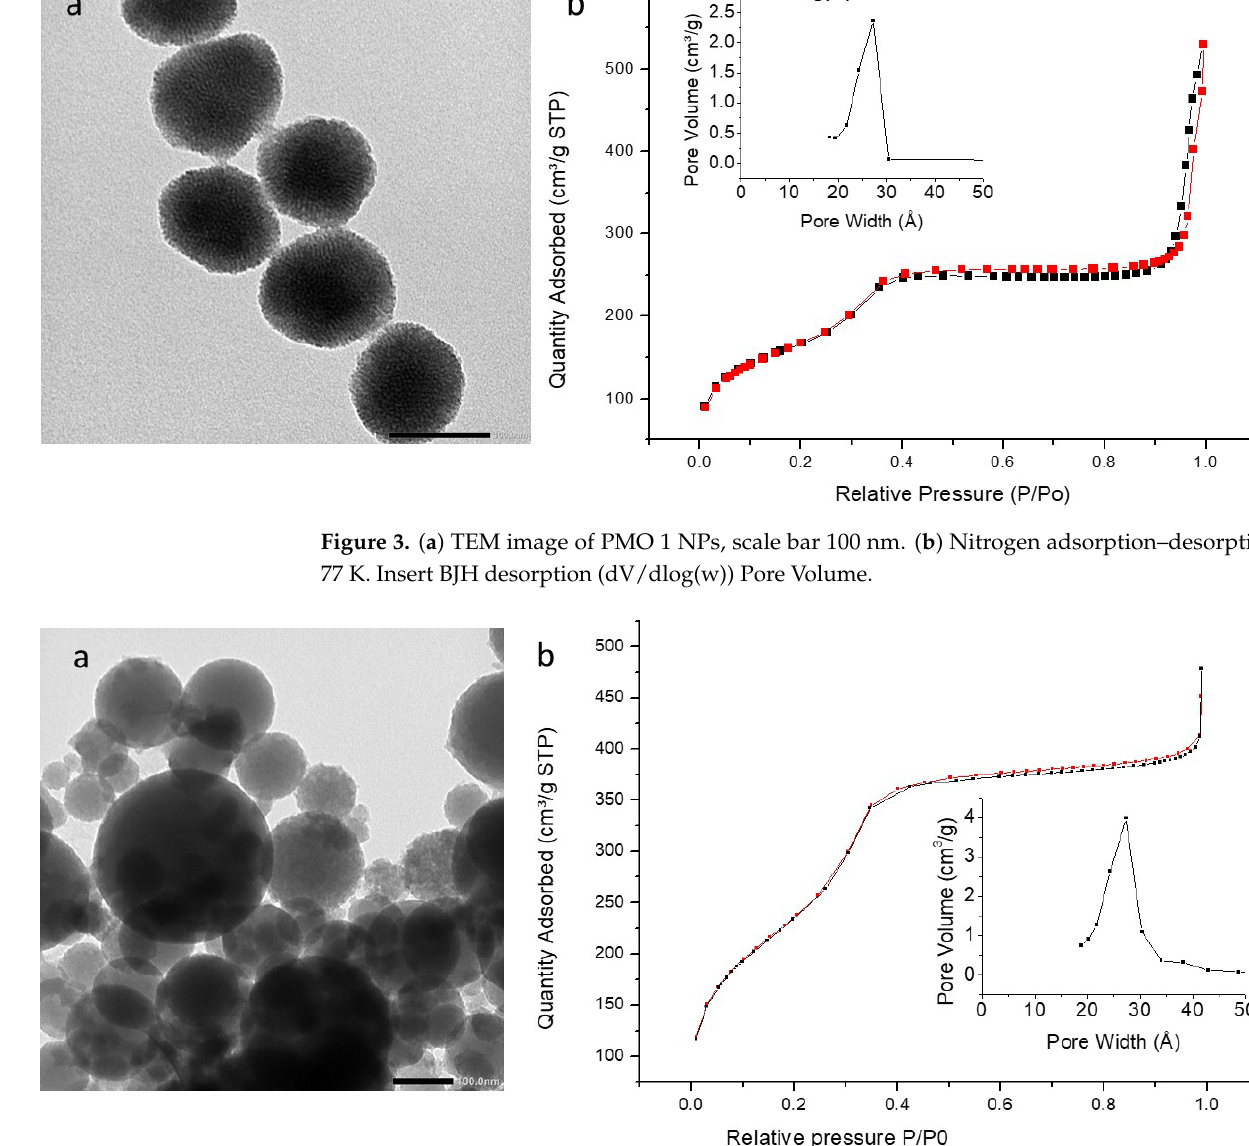
Figure 4. ( a ) TEM image of PyPMO 6 NPs scale bar 100 nm. ( b ) Nitrogen adsorption–desorption at 77 K. Insert BJH desorption (dV/dlog(w)) Pore Volume.